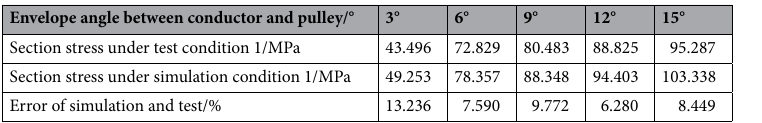
Table 13. Data comparison between the simulation condition 1 and the test condition 1.